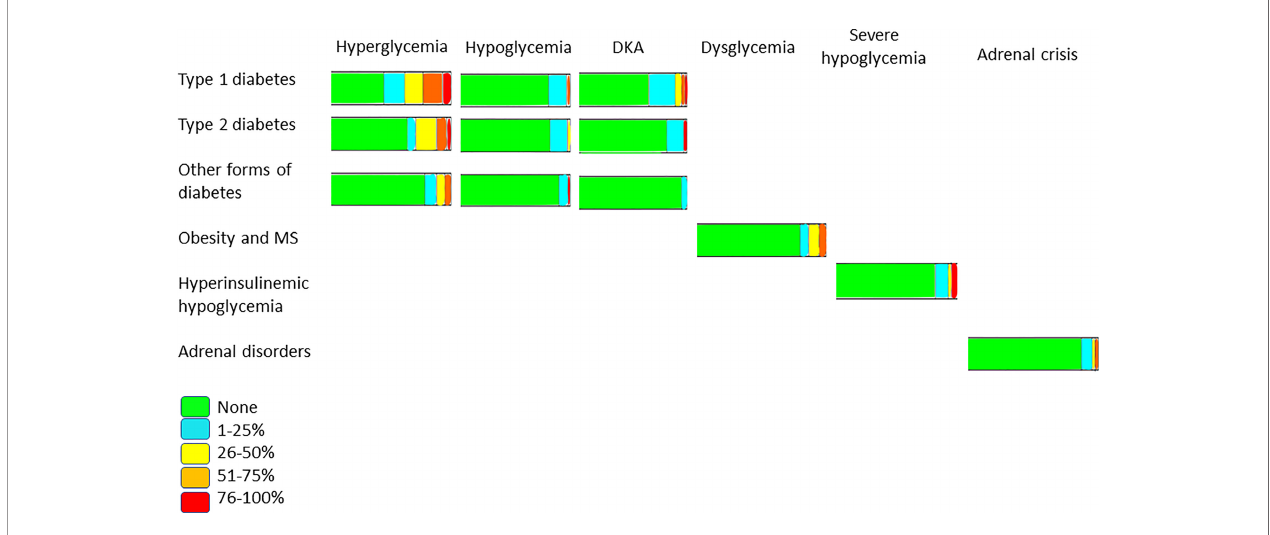
FIGURE 2 | Proportion of speci fi c symptoms in COVID-19 patients among pediatric endocrine